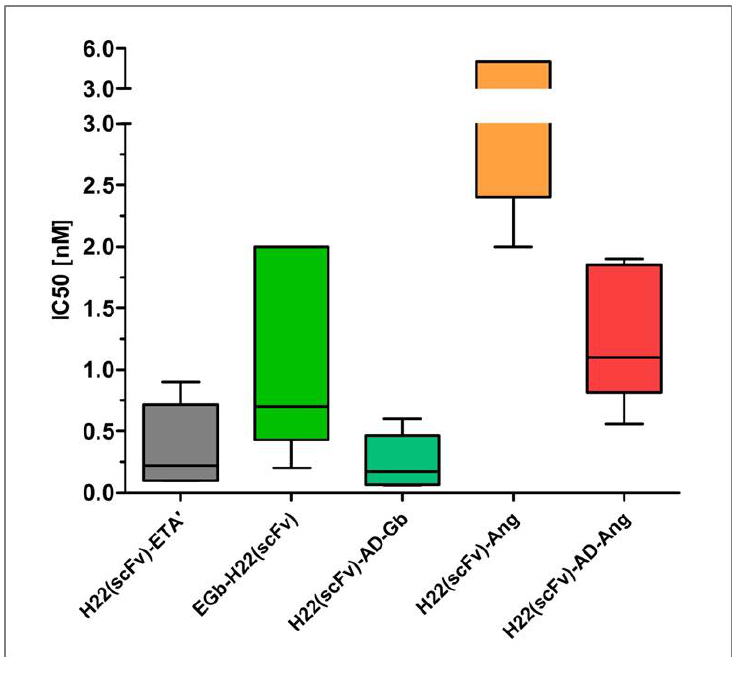
Figure 2. Box plot of IC values: Five IC values determined in the XTT viability assays 50 50 are compared for H22(scFv)-ETA', EGb-H22(scFv), H22(scFv)-AD-Gb, H22(scFv)-Ang, and